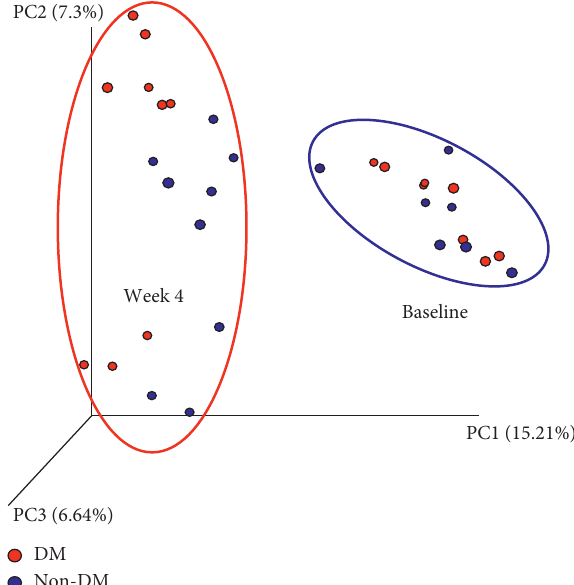
Figure 2: β -diversity analysis (unweighted UniFrac) of baseline and week 4 microbiota of DM and control (non-DM) rats. Although the rats at baseline are labelled DM, they have not been induced with STZ yet, but would become DM later in the